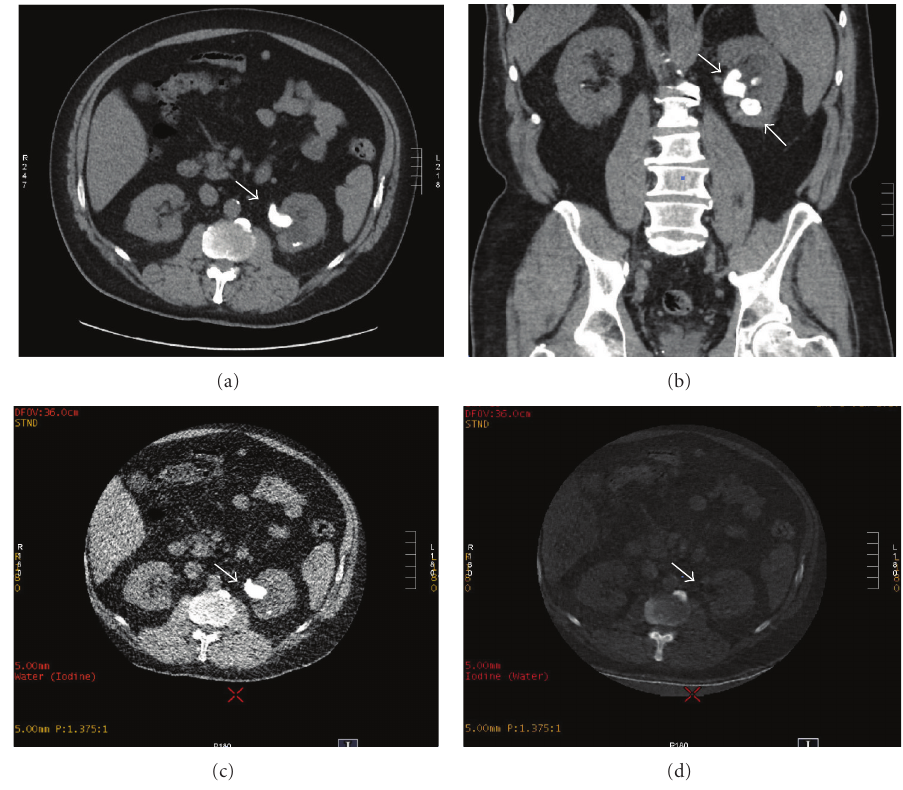
Figure 3: A 42-year-old male with a history of renal calculi presenting with left flank pain. Noncontrast CT for the assessment of renal calculi in axial (a) and coronal (b) reformats. These images clearly show a large calculus in the left renal pelvis extending into the upper ureter as well as a second large calculus in the lower pole of the left kidney (arrows). Axial dual energy noncontrast CT images in the same patient showing iodine- (c) and water- (d) based attenuation. The calculus is visible on the iodine-attenuated image (c) and is unchanged when compared to the standard CT. However, the water-attenuated image (d) shows “dropout,” and the calculus is no longer visible. This indicates the presence of low-molecular-weight elements. Post removal, this stone proved to be predominantly composed of